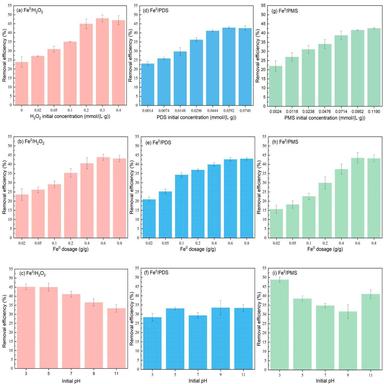
Effects of oxidant initial concentration, Fe0 dosage, and initial pH on the degradation of petroleum hydrocarbons in OBDC by the Fe0 /PMS, Fe0 /PDS, and Fe0 / H2O2 advanced oxidation systems. (Reaction conditions: room temperature, liquid/solid ratio = 10:1, H2O2 = 0.1 mmol/(L⋅g), PDS = 0.0592 mmol/(L⋅g), PMS = 0.0952 mmol/(L⋅g), Fe0 = 0.4 g/g, initial pH = 3.0, and t = 120 min).